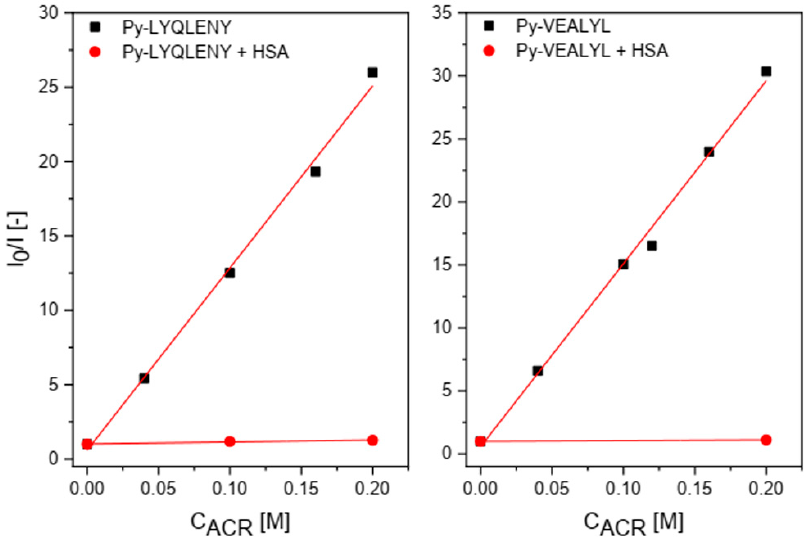
Figure 5. Stern–Volmer plots for quenching of Py-LYQLENY and Py-VEALYL by ACR in the buffer and HSA solution. I 0 is fluorescence intensity without quencher, I—fluorescence intensity at various concentrations of ACR, [HSA] = 30 µM.